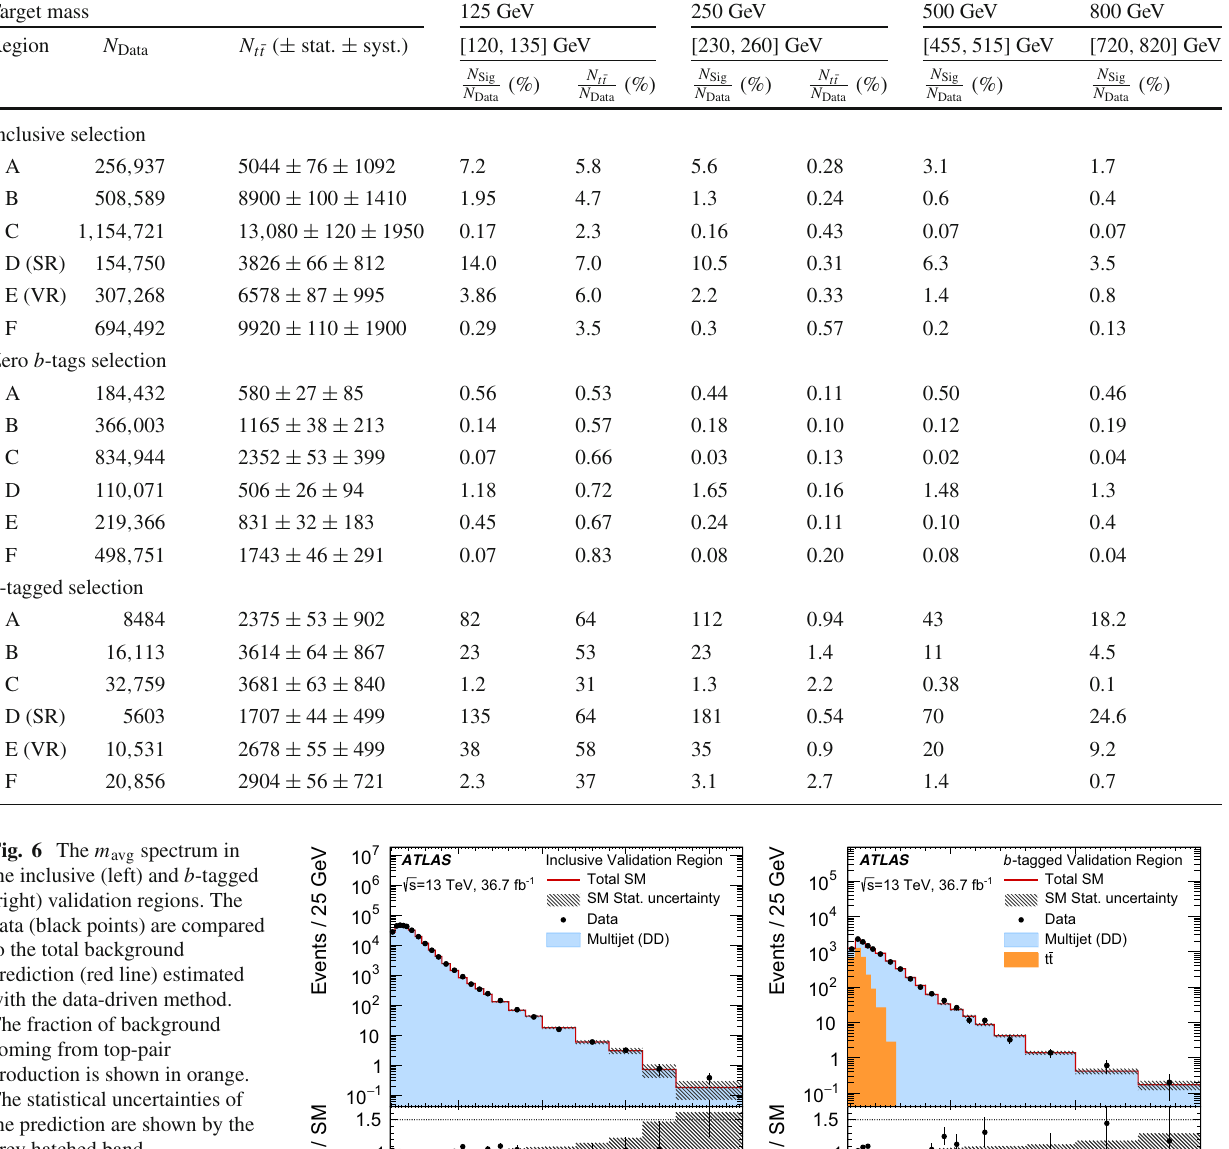
shown. The t ¯ t systematic uncertainties include both the detector-level uncertainties and the theoretical uncertainties, as described in Sect. 8